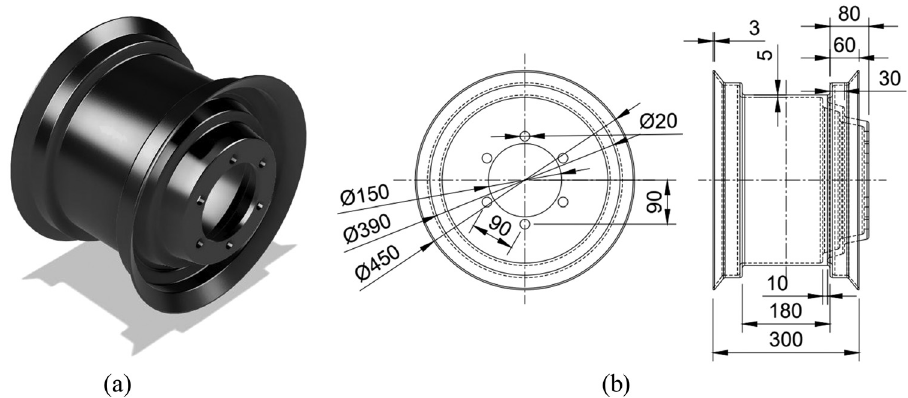
Figure 1: ( a ) Rim wheel design in 3D and ( b ) rim wheel design in 2D. All sizes are in mm.